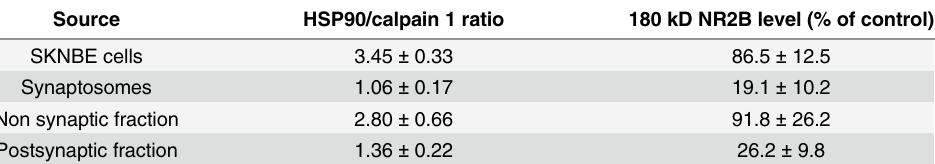
Postsynaptic fraction 26.2 ± 9.8 HSP90/calpain 1 ratio values were extrapolated from Fig 7A (for SKNBE cells and synaptosomes), and from Fig 8C and 8E (for non synaptic and postsynaptic fractions, respectively). Native NR2B levels were extrapolated from Fig 7C (for SKNBE cells and synaptosomes), and from Fig 8C and 8E (for non synaptic and postsynaptic fractions, respectively), and were calculated as percentage of control following 12 min- exposure to NMDA. Data are presented as the arithmetical mean ±